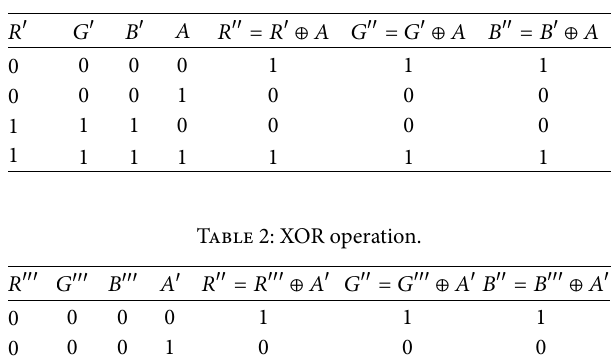
Table 1: XOR operation.